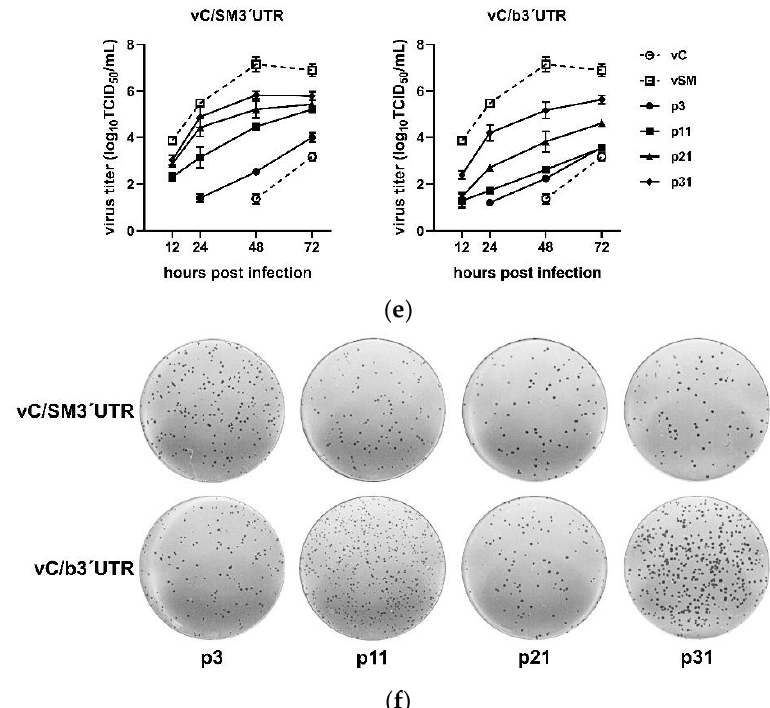
Figure 1. Rescue of chimeric classical swine fever virus (CSFV) vaccine C strains containing pestivirus 3 (cid:48) UTR substitution and characteristics of passaged viruses. ( a ) Schematic representation of the cDNA clones of chimeric CSFV C strains containing 3 (cid:48) UTR substitution. ( b ) Rescue of infectious chimeric viruses vC/SM3 (cid:48) UTR and vC/b3 (cid:48) UTR. PK-15 cells infected with the culture supernatant of transfected cells were analyzed by immunofluorescence (IF) staining with an NS3-specific antibody at 24 h post-infection. The microscopy images were captured at 100 × magnification. ( c ) Genome replication efficiency of passaged viruses. PK-15 cells were infected with passaged chimeric viruses p3, p11, p21, and p31 at an MOI of 0.001, respectively. The total RNA was extracted from the infected cells at the indicated times and viral RNA copy numbers were determined by qRT-PCR. The results were recorded from three independent experiments. ns, no significant; *, p < 0.05; **, p < 0.01. ( d ) Virus titers of passaged viruses. PK-15 cells were infected with passaged viruses at an MOI of 0.01. Virus